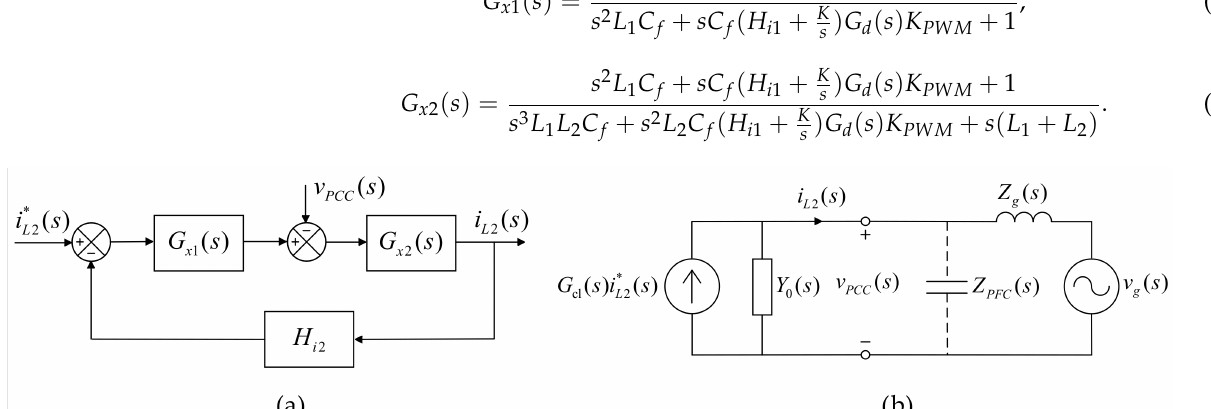
Figure 11. Simplified block diagram and the derived equivalent circuit [19]: ( a ) Equivalent form of Figure 10; ( b ) Norton equivalent circuit of a grid-connected